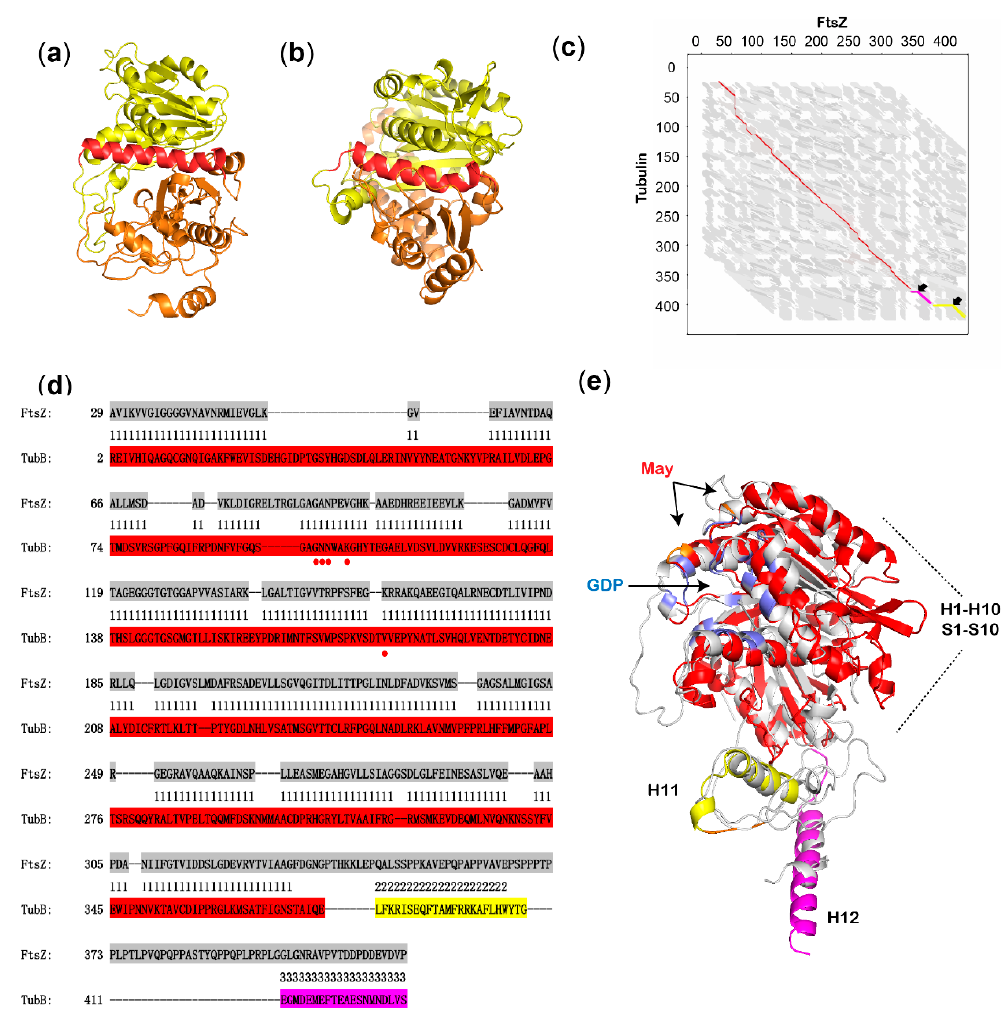
Figure 2. Structure comparison of FtsZ and β -tubulin. ( a ) The architecture of FtsZ from A. pretiosum WXR-24, built by homologous modeling. The featured α -helix 7 is labeled in red, connecting the yellow-labeled N-terminal domain and orange-labeled C-terminal domain. ( b ) The architecture of β -tubulin from Bos taurus retrieved from PDB database. The featured α -helix 7 is labeled in red, connecting the yellow-labeled N-terminal domain and orange-labeled C-terminal domain. ( c ) The graph of flexible structure alignment of FtsZ and β -tubulin. Three large structurally conserved blocks are shown in red, yellow or pink, and 2 twists are indicated by black arrows. ( d ) Sequence-based structural alignment of FtsZ and β -tubulin. FtsZ is highlighted in grey, and structurally conserved blocks in β -tubulin are highlighted in red, yellow or pink. The key amino acids of β -tubulin interacting with maytansine are indicated by red dots. ( e ) Superposition of the 3D structures of FtsZ and β -tubulin. FtsZ is colored in grey, and structurally conserved blocks in β -tubulin are in red, yellow or pink. The GDP-binding pockets of FtsZ and β -tubulin are labeled in blue, and the maytansine-binding pocket on β -tubulin is labeled in orange. May, maytansine.